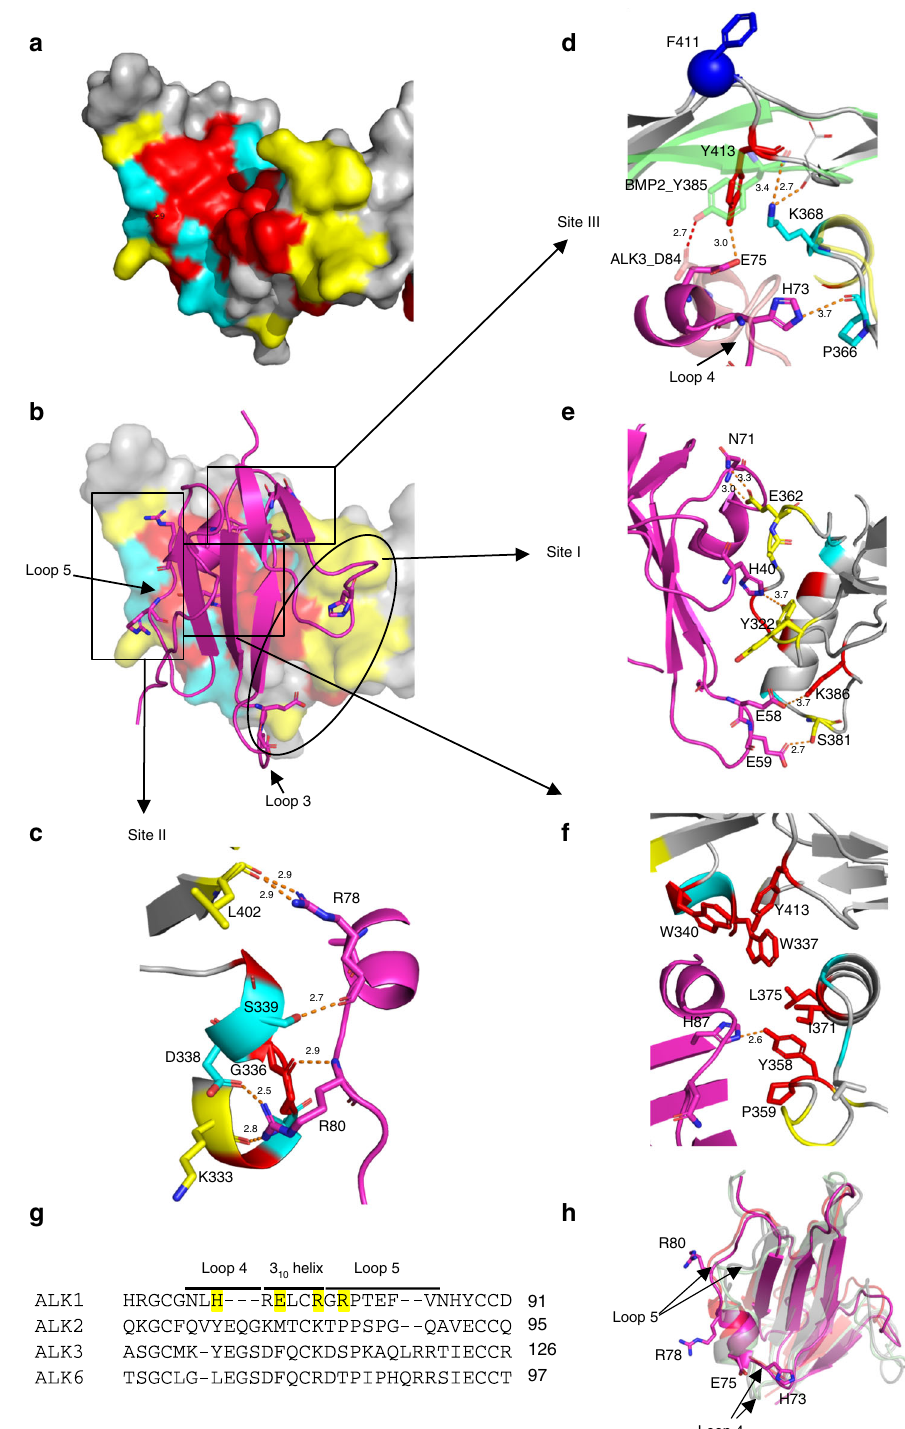
Fig. 4 Conserved region 1 and ALK1-speci fi city determinants. a ALK1-binding residues are mapped onto the BMP10 surface (grey), with those conserved across all BMPs in Fig. 3a coloured in red, those from the BMP9 and BMP10 conserved region 1 in cyan, and other variable residues in yellow. b ALK1 (magenta cartoon) binding to BMP10 (surface), with residues interacting with BMP10 shown in sticks. c – f Detailed interactions between BMP10 and ALK1. g Sequence alignment of four BMP-binding type I receptors, ALK1, ALK2, ALK3 and ALK6, with the four speci fi city-determining residues in ALK1 highlighted in yellow. Loop 4 and loop 5 are the two loops surrounding the 3 10 helix (Supplementary Fig. 4). h Overlaid structures of BMP type I receptors. The structure of ALK1 in the BMP10:ALK1 complex (magenta) is overlaid onto ALK1 in BMP9:ALK1 complex (PBD:4FAO, orange), ALK3 (PDB:2GOO, light green) and ALK6 (PDB:3EVS, light grey). ALK1 residues highlighted in g are shown in